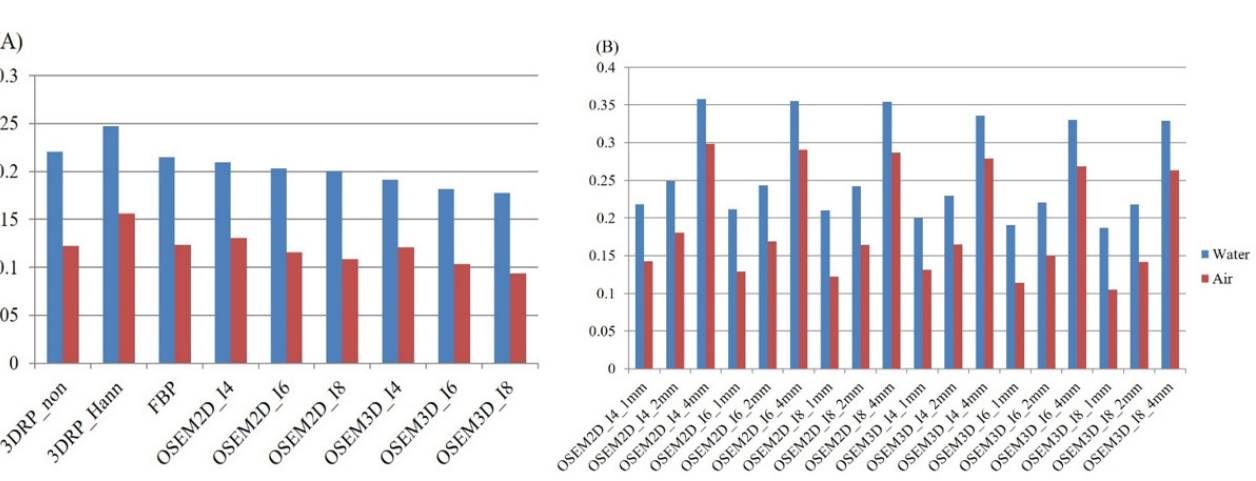
Figure 4. The spillover ratio (SOR) was estimated as the mean of uniform area to the mean of water or air area. ( A ) The SOR in water was significantly higher than that in air in the reconstruction methods without Gaussian post-filtering ( p < 0.001). ( B ) In the iterative methods, SOR decreased with increasing iteration number and increased with increasing Gaussian filter size ( p < 0.05).